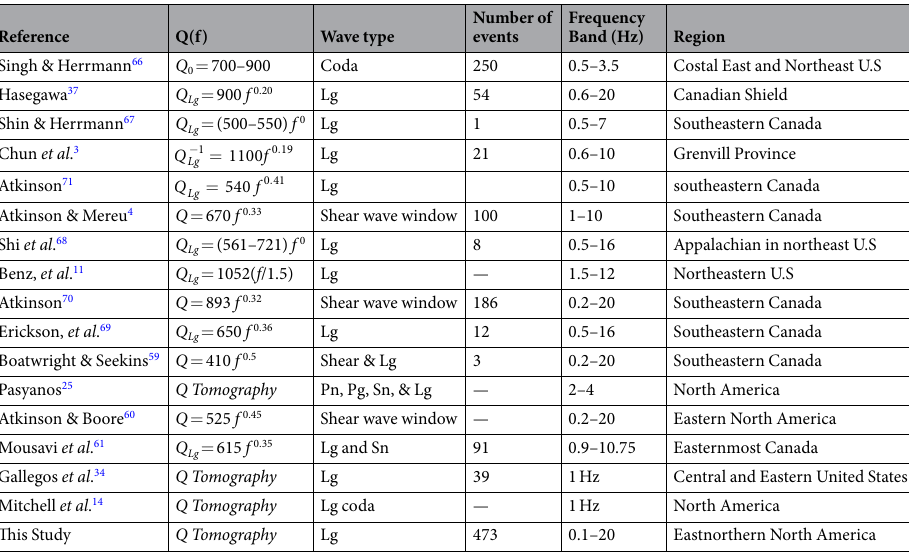
Table 1. Previous attenuation studies at the